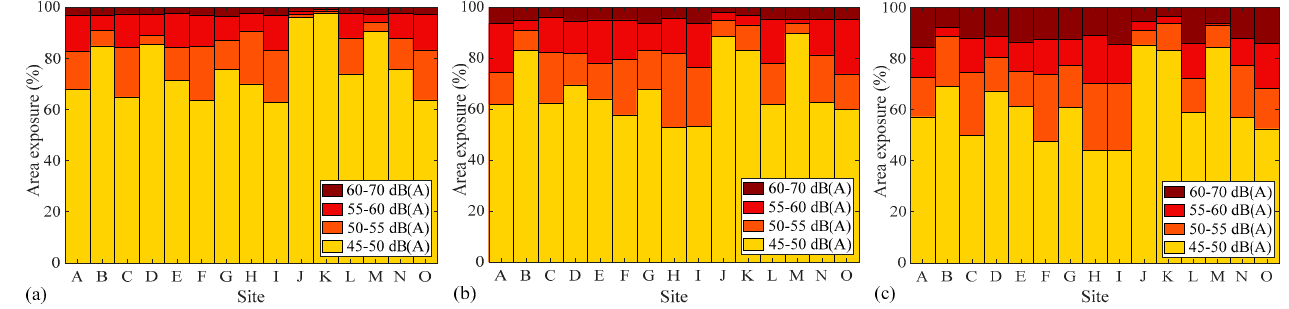
Figure 6. Area exposure proportions of noise levels, L A,eq , for the fifteen sites under different numbers of air filters (( a ) two air filters; ( b ) four air filters; ( c ) six air filters).